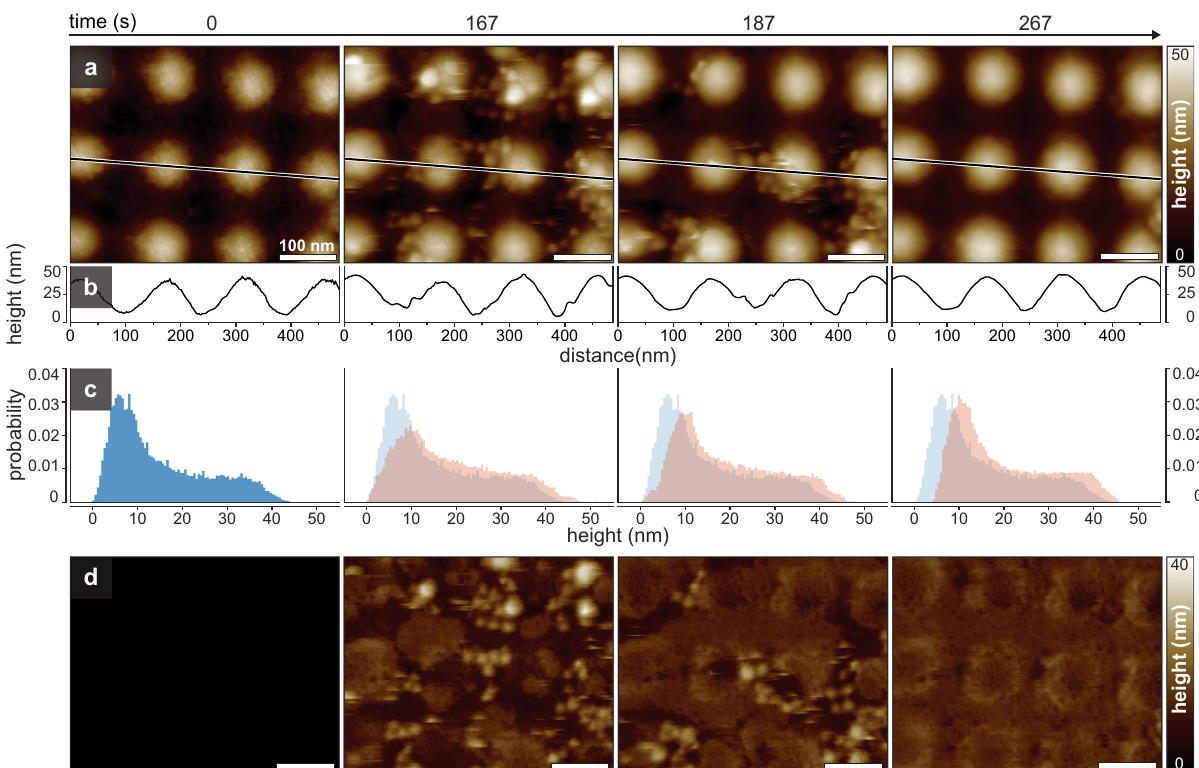
Fig. 1 Time-lapse of SLB formation on undulated (concave-convex) nanopatterned HS-AFM supports. a HS-AFM frames (Supplementary Movie 1) of the bilayer formation process: t = 0 s: Non- fl at sample surface before addition of lipid. t = 167 s: SUVs deposit on the surface. t = 187 s: Vesicles start to spread and fuse to form a SLB. t = 267 s: The entire surface is membrane covered. b Line pro fi les along the dashed lines in a . c Height distribution histograms of the images shown in a : Height values shifted over time by the thickness of a bilayer (~4 nm; compare blue and orange height distributions at t = 0 s and t = 267 s, respectively. d Nanopattern-subtracted images of the images shown in a . Source data are provided as a Source Data fi